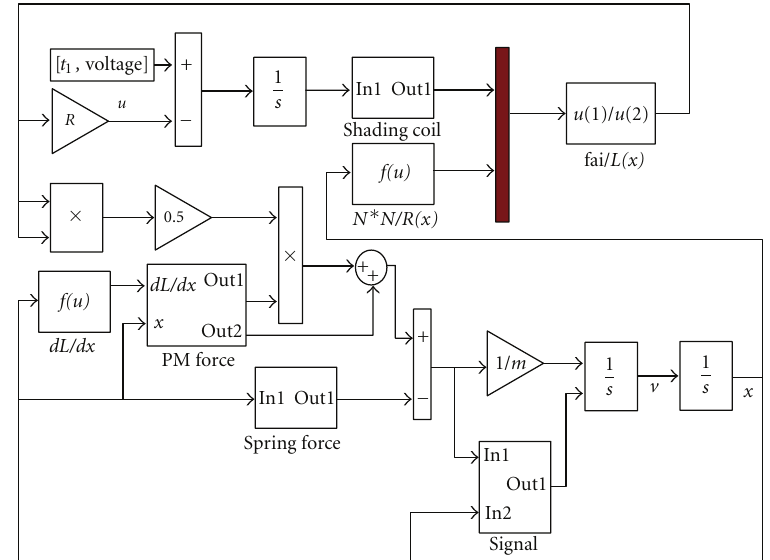
Figure 7: It shows the complete simulation